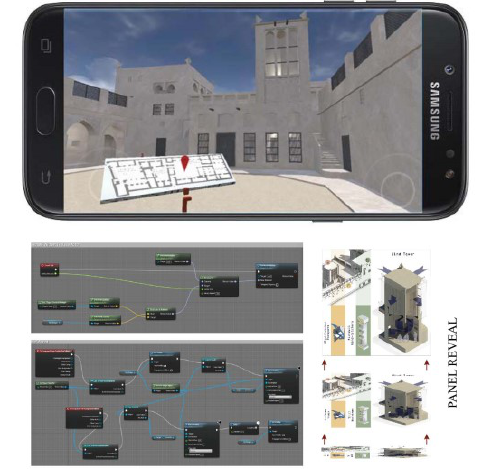
Figure 12. VR project for mobile phones (i) based on EU4 blueprints (ii).